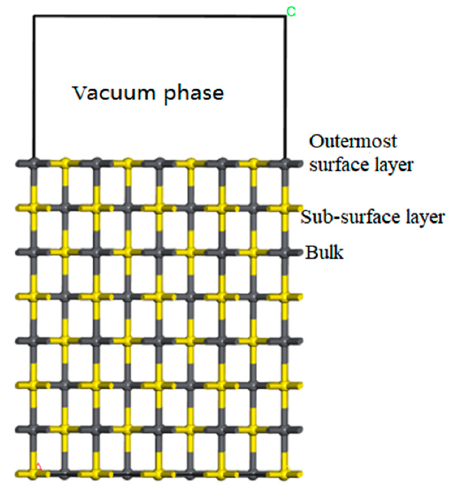
Figure 9. Outermost surface layer, sub-surface layer, and bulk on (100) surface of galena (Yellow: S atom; Gray: Pb atoms).